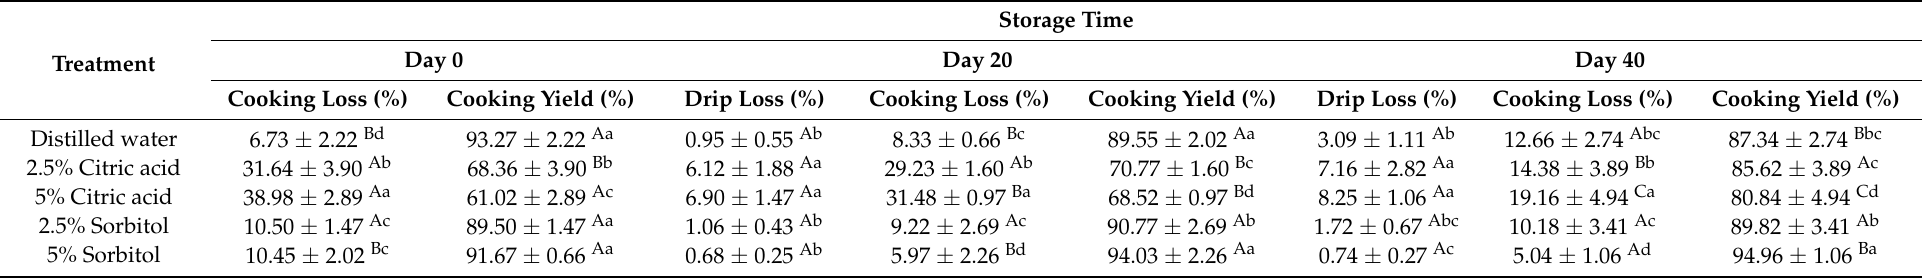
Table 2. Drip loss, cooking loss, and cooking yield of frozen fish fillets soaked with different solutions after thawing during frozen storage